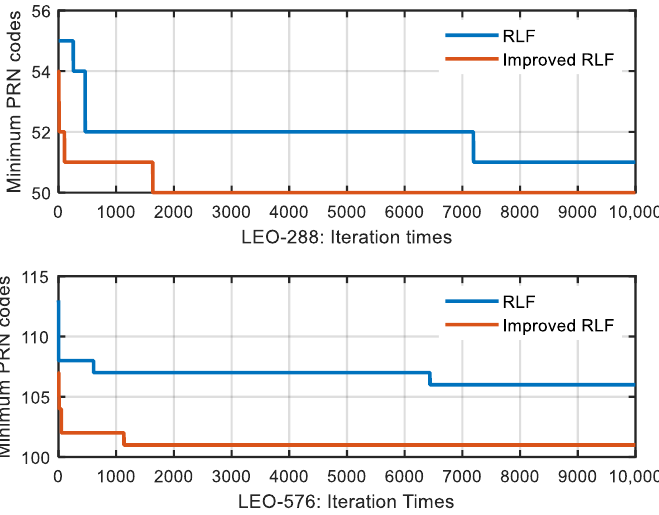
Figure 8. Comparison of minimum PRN codes between the RLF algorithm and the improved-RLF algorithm. The satellite configuration was the walker 288/12/6 at an altitude of 1000 km and the walker 576/24/12 at an altitude of 900 km. Both the RLF and improved-RLF were run once with 10,000 iterations.